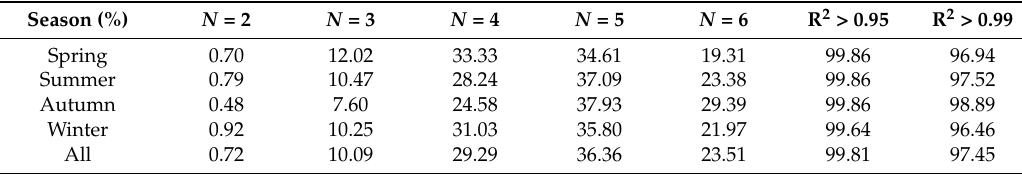
Figure A9. ( a , b ) R 2 and RMSE (molec./cm 2 ) for the Gaussian simulation of the NH 3 profiles 5~55 ◦ N) in 2013. (68~142°E, 5~55°N) in 2013. Table A1. Descriptive statistics for results of Gaussian Table A1. Descriptive statistics for results of Gaussian simulation.